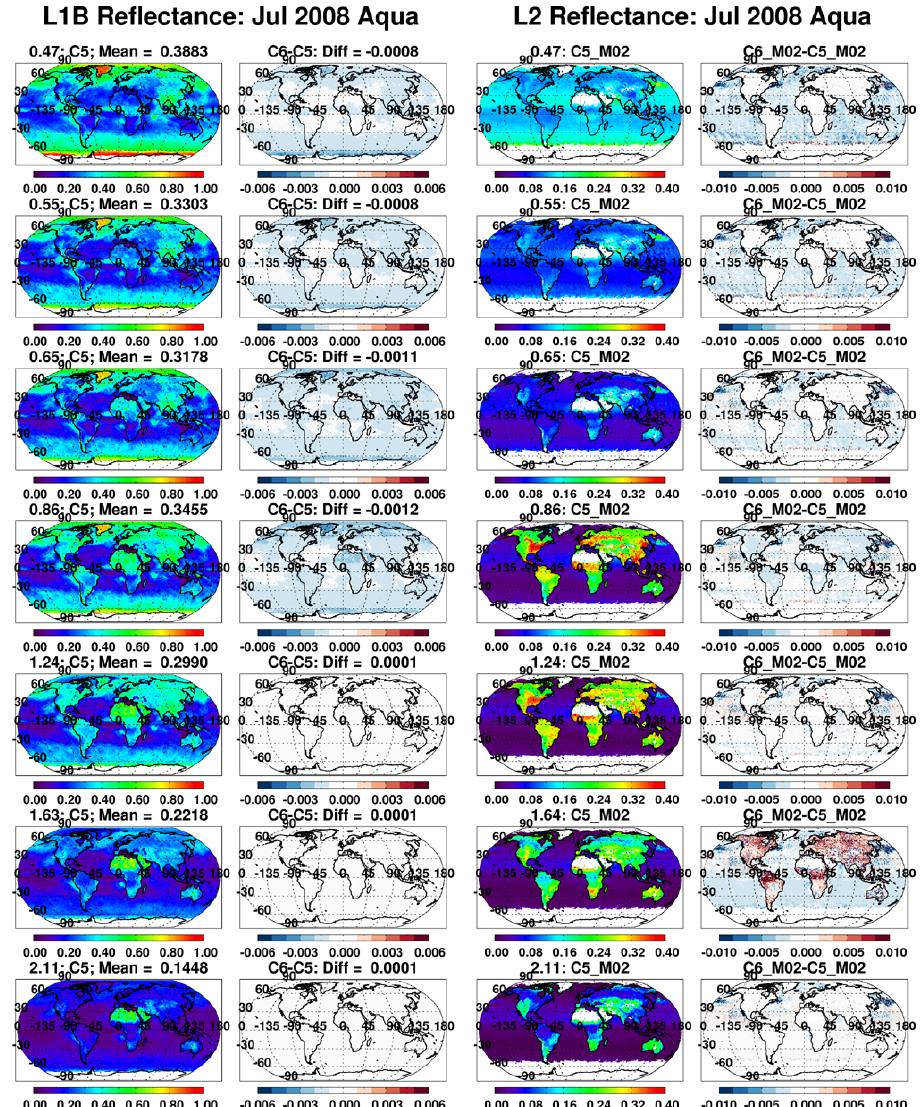
Fig. 3. Gridded “average” reflectance from Aqua for July 2008, demonstrating how small updates to L1B calibration can contribute to larger impacts on L2 products. For each wavelength band (row), the two left panels are calculated from L1B reflectance at 1km (MYD021KM), and the right two panels are calculated from L2 reflectance at 10km (MYD04_L2), which represents the reflectance used to derive the aerosol parameters. For the left two panels (L1B), the 1st is derived from C5 data, and the 2nd is the change due to using C6 (C6–C5). For the right panels (L2), the 1st is from the C5 aerosol algorithm if using C5 MOD02 inputs (the C5 aerosol product), whereas the 2nd shows the change if using the same C5 aerosol algorithm, but replacing with C6 MOD02 inputs. Note differences in the color scales for the two sets of panels.